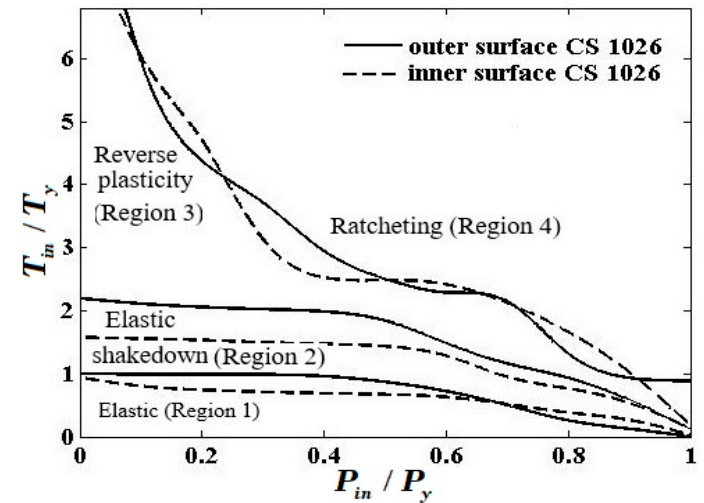
Figure 13. Bree’s diagram: interaction diagram for internally pressurized FGM cylindrical shell subjected cyclic temperature difference through-thickness for two FGM profiles including the inner and outer surfaces made of CS 1026.